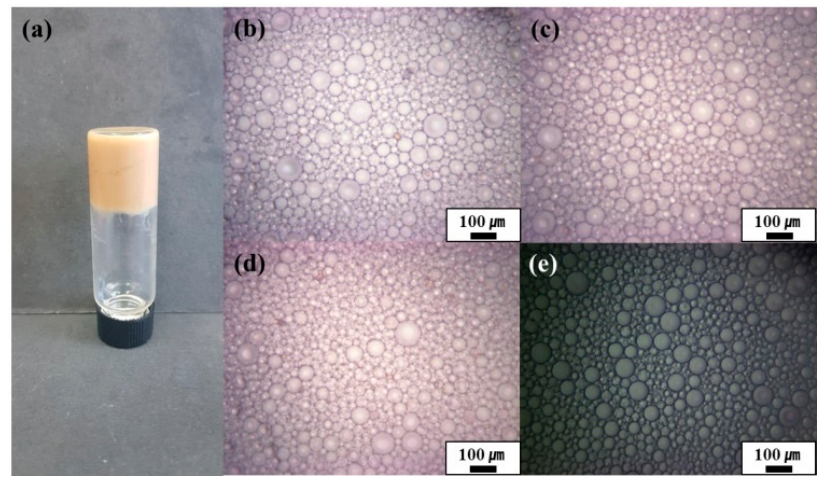
Figure 3. Optical micrographs of Pickering HIPEs prepared with 6 wt.% PAAS and 80 vol.% internal phase using oligoimide particle concentrations of ( b ) 1 wt.%, ( c ) 3 wt.%, ( d ) 5 wt.%, and ( e ) 0 wt.%. ( a ) A photograph of the Pickering HIPE shown in ( d ).